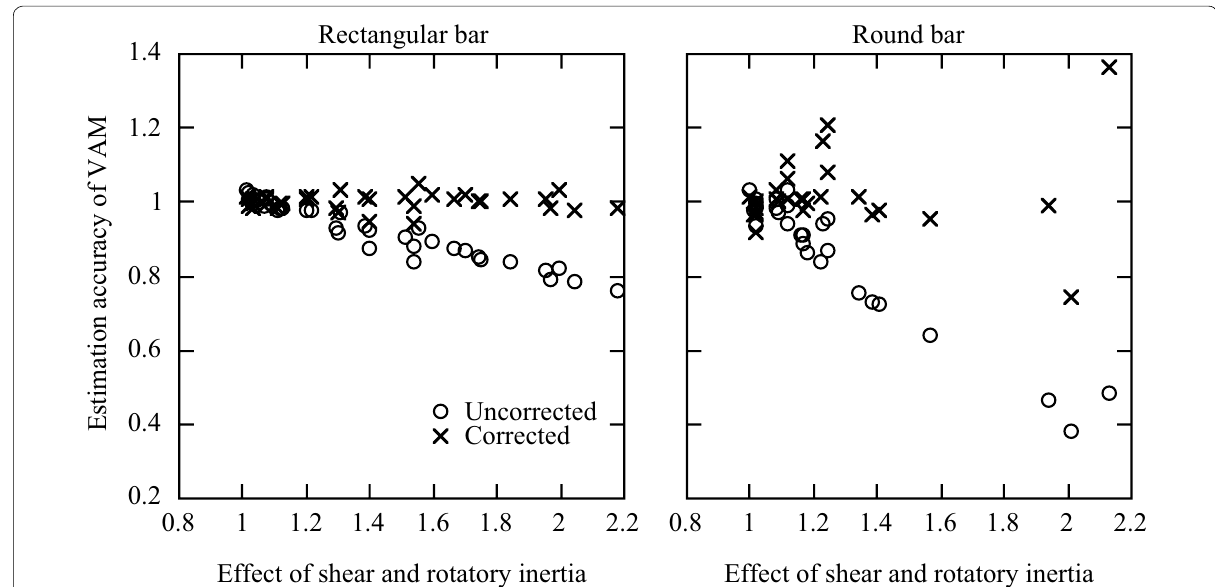
Fig. 5 Relationship between the estimation accuracy of the VAM and the effect of deflections due to shear and rotatory inertia involved in the bending vibrational deflection